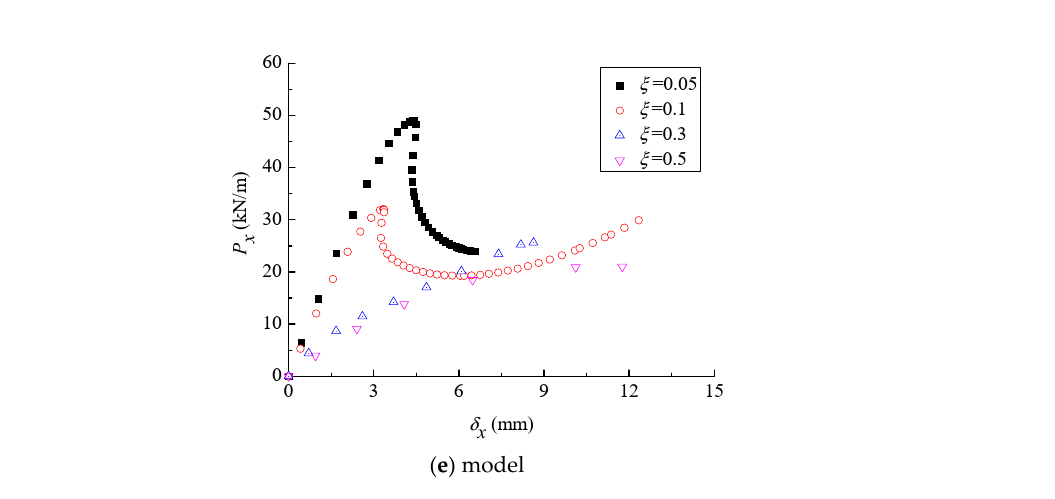
Figure 14. Comparison of the predicted and original load vs. end-shortening curves of the T-type stiffened cylinders with the SS3 boundary when the model material is PVC.